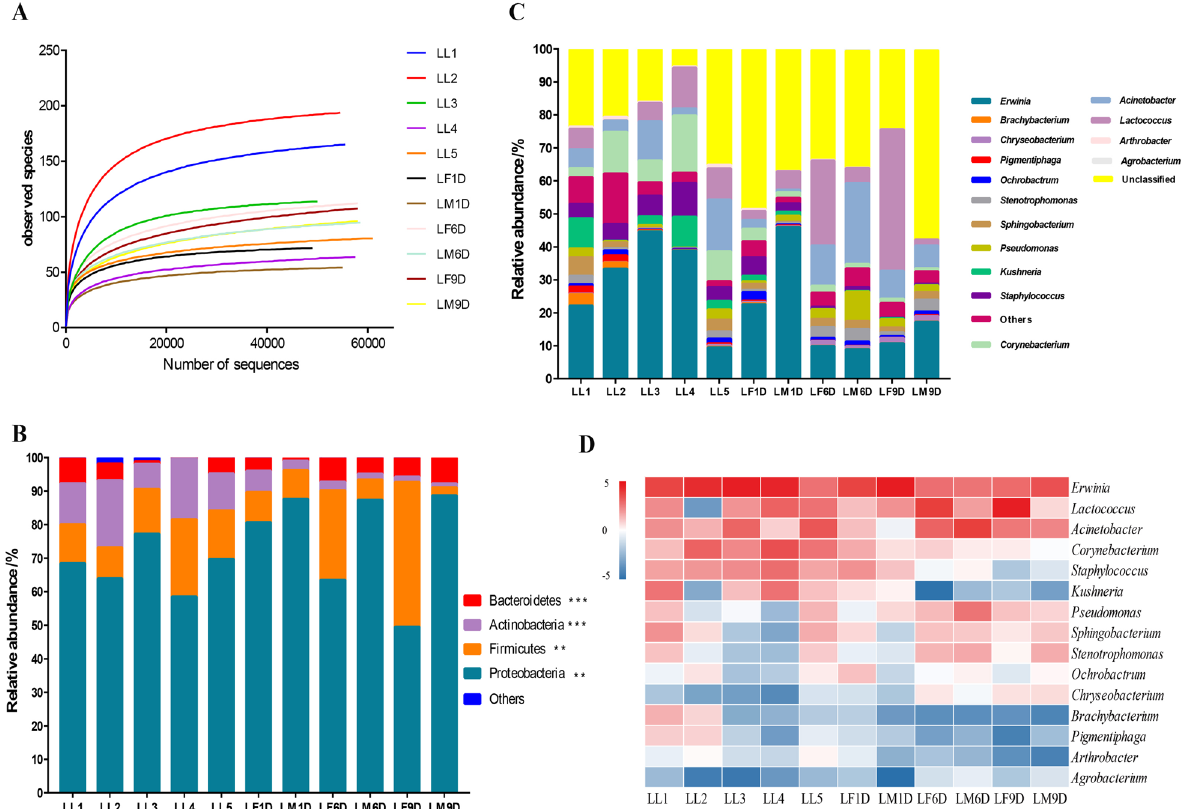
Fig. 1 Bacterial community dynamics among different developmental stages in Apolygus lucorum . A Observe species dilution curve. B Relative abundance of bacteria communities at the phylum level in different groups. C Relative abundance of bacteria communities at the genus level in different groups. D Heat map analysis of the top 15 microbial populations with relative abundance at different developmental stages, and the data represented by color in the figure are represented by log 2 (relative abundance). (Bacteria with relative abundance lower than 0.1% in all samples were all merged into others. The “Kruskal–Wallis test” was used to analyze the differences of phyla at all developmental stages. * 0.01 0.001 P < 0.01, and *** P < ≤